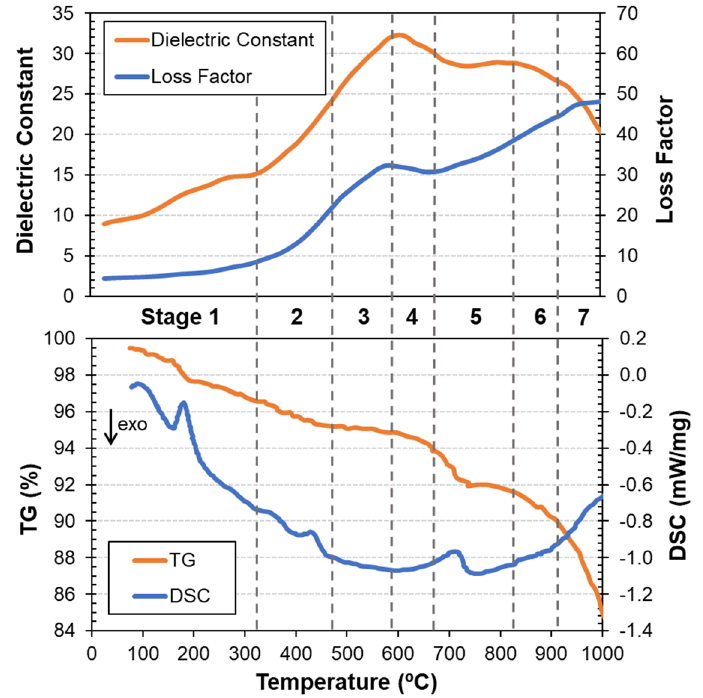
Figure 2. Dielectric properties and thermal analyses (thermogravimetry (TG) and differential scanning calorimetry (DSC)) of reference sample (C/O = 100%) as a function of temperature.